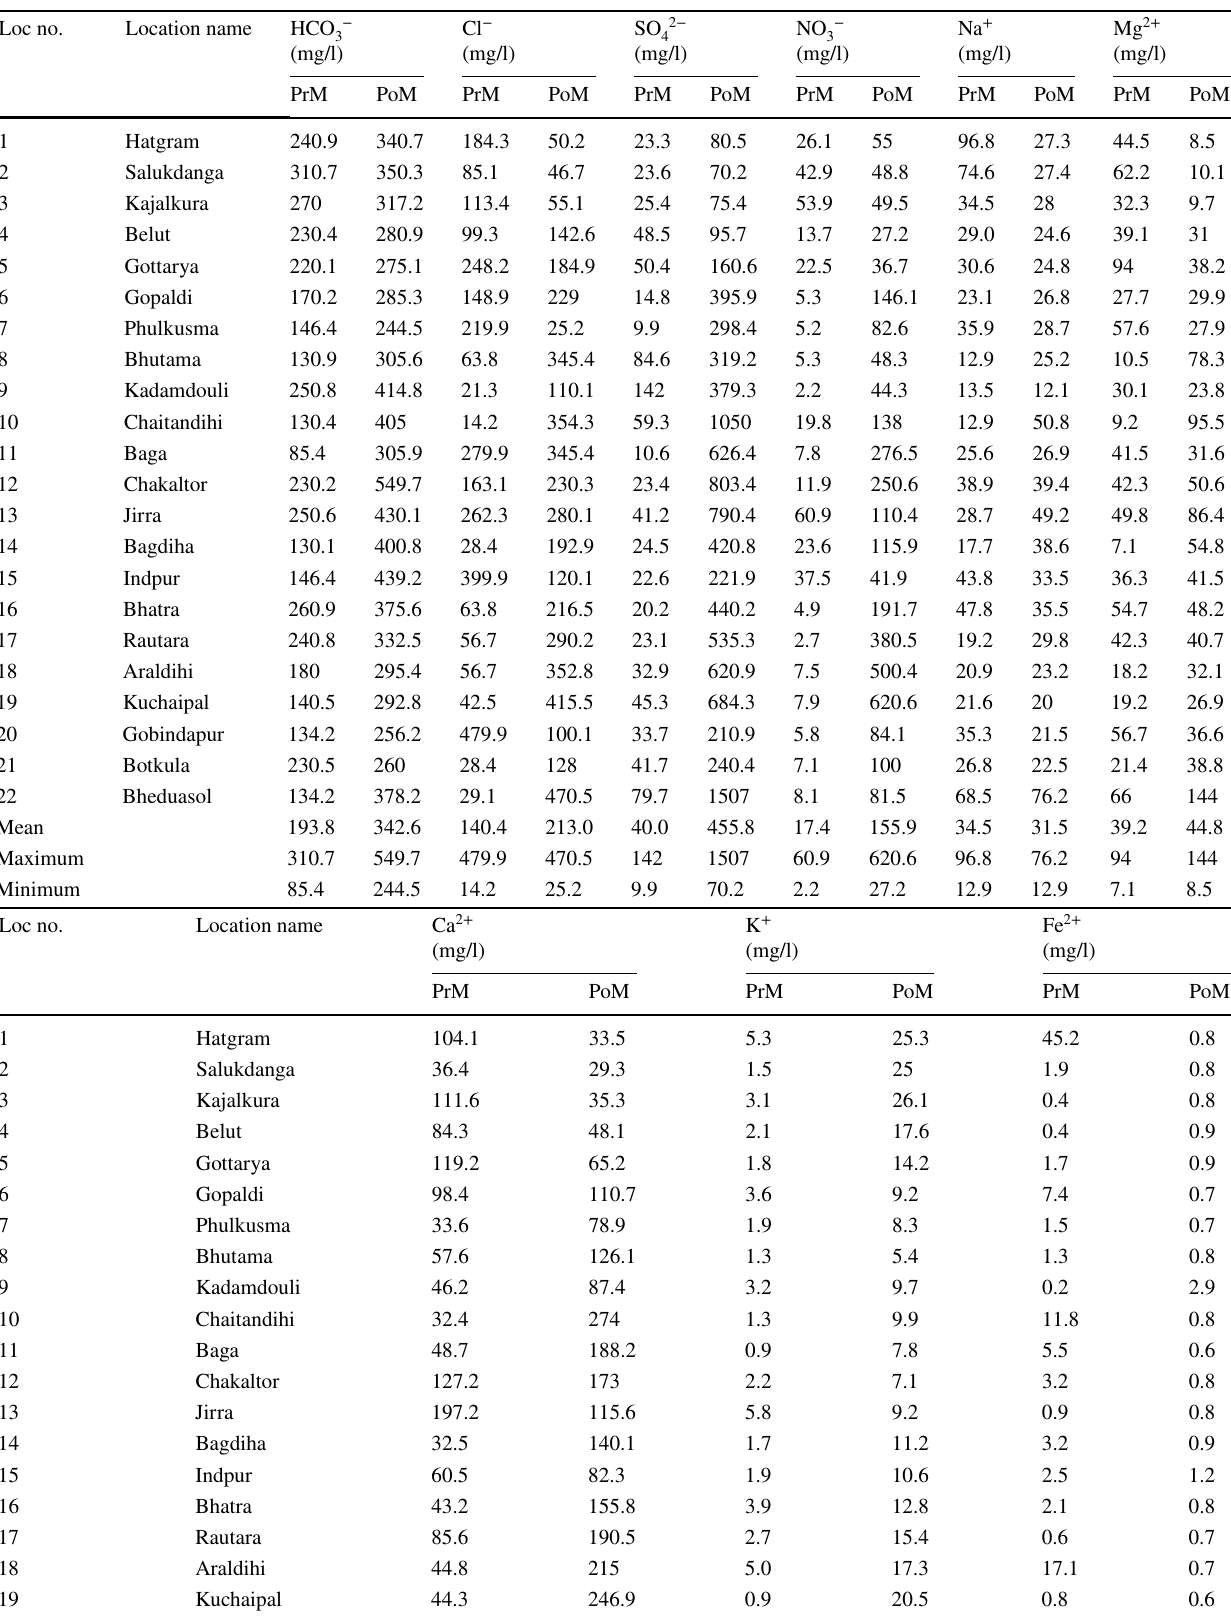
Table 3 Concentrations and seasonal variations of major ions in the water samples of the studied block Loc